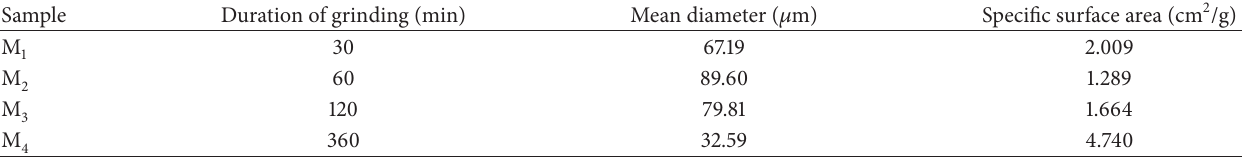
Table 2: The results of changes in the mean diameter and specific surface area of the particles.